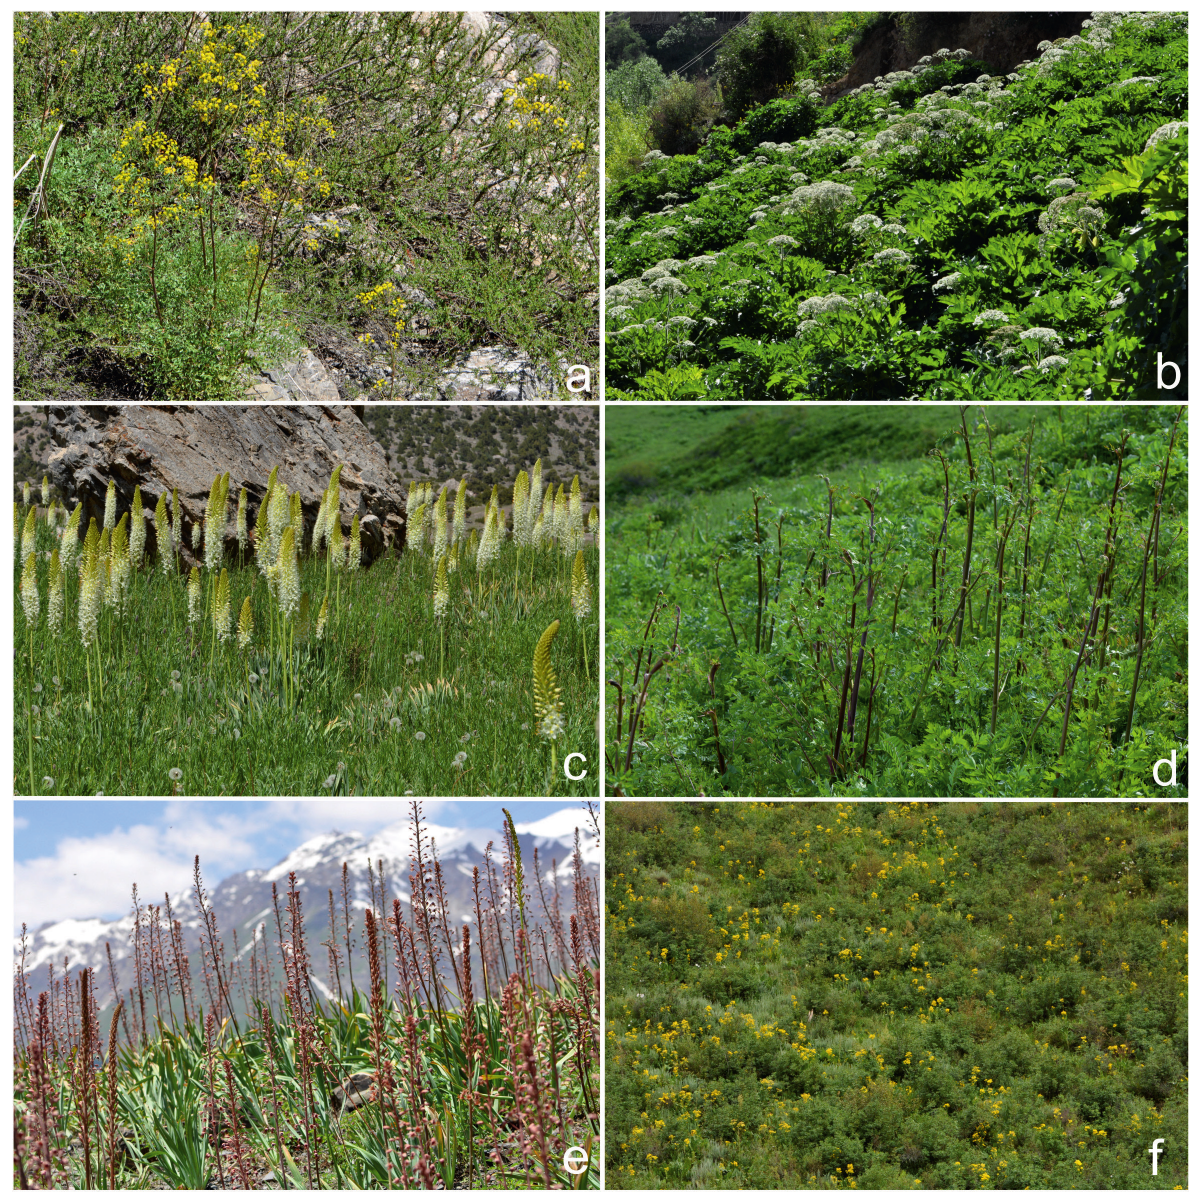
Figure 6. Photographs of the tall-forb vegetation belonging to: a – Feruletum sumbuli in the Haf-kul Valley in the Funn Mts, Western Pamir-Alai; b – Heracleetum lehmannianii on the slope water outflow in Haf-kul Valley, Western Pamir-Alai, approx. 1,850 m a.s.l.; c – Eremuretum kaufmannii in the Kuli-kalon Plateau in Funn Mountains, approx. 3,400 m a.s.l.; d – Anthriscidetum glacialis near the Hoburobot Pass in Darvaz Mountains, approx. 3,500 m a.s.l.; e – Eremuretum stenophyllido-comosi in Mayhura Valley in Hissar Mountains, approx. 2,650 m a.s.l.; f – community of Inula macrophylla near Chilishtak Village in Darvaz Mountains, approx. 1,450 m